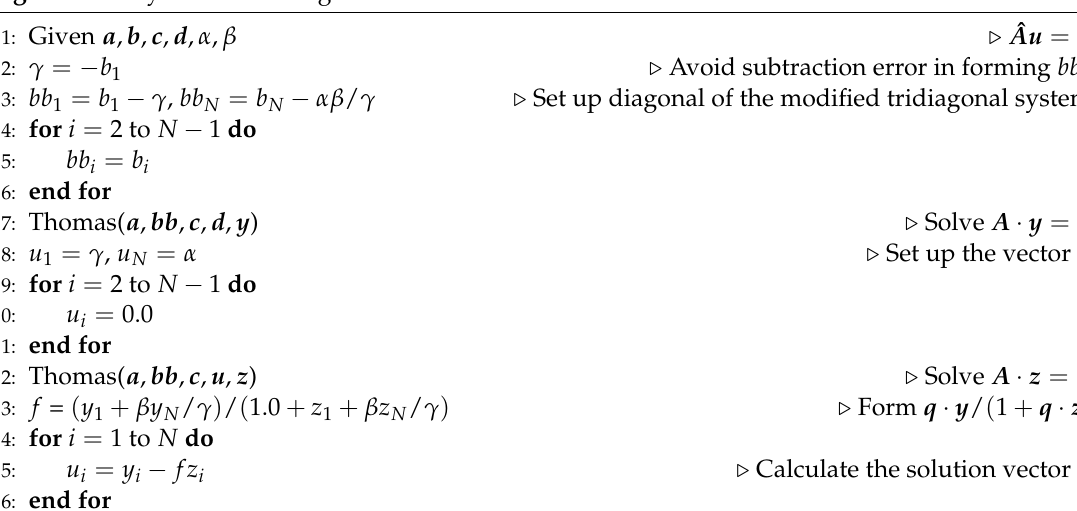
Algorithm 2 Cyclic Thomas